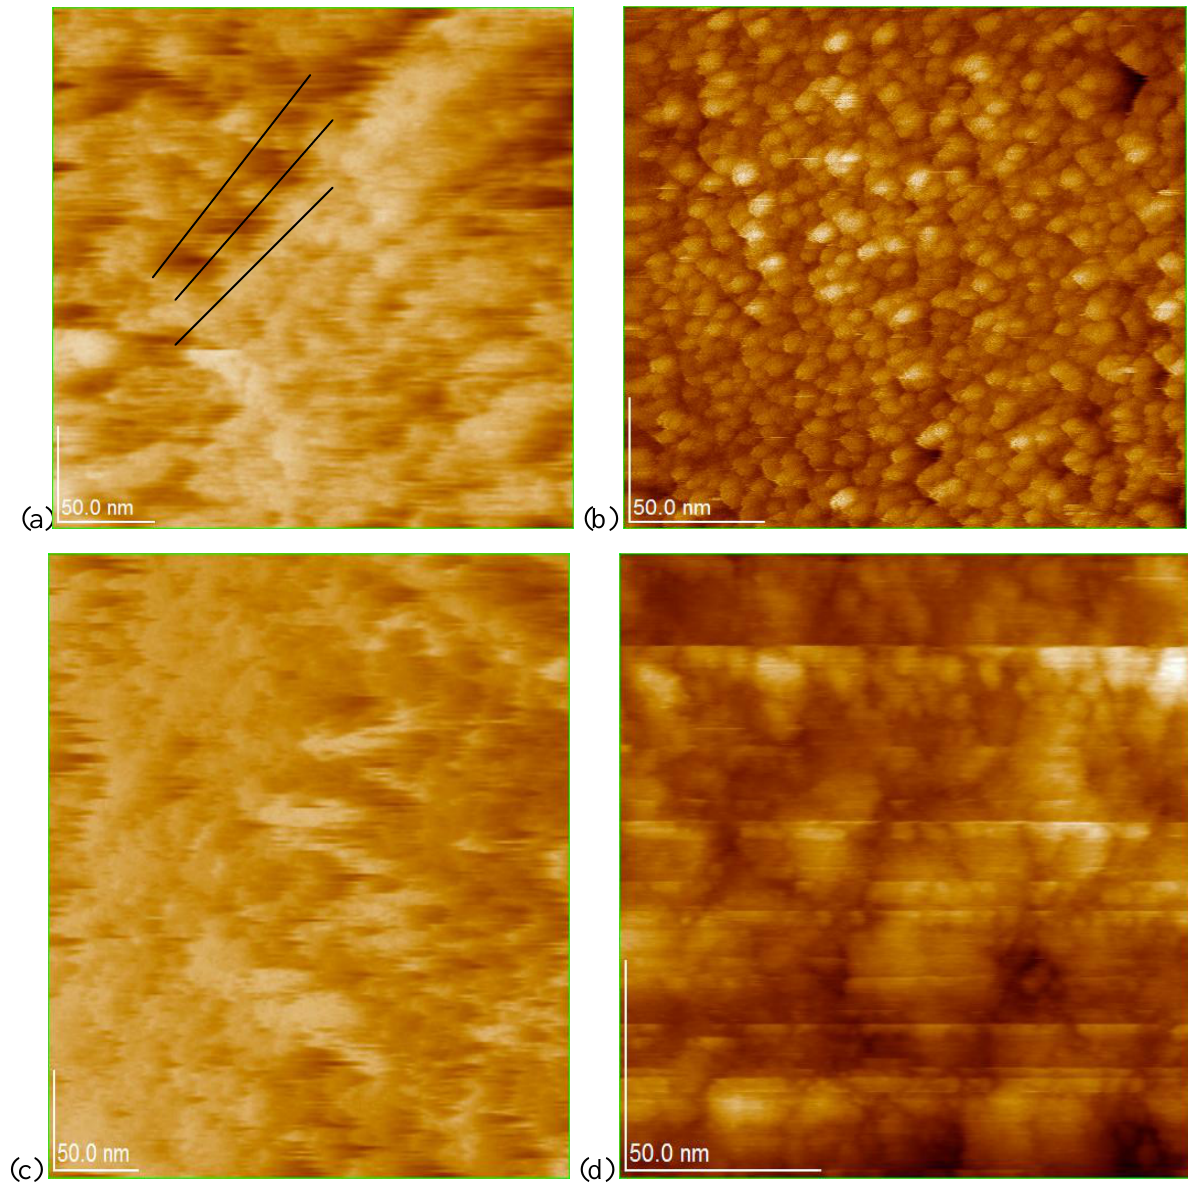
Figure 6. STM images of (a) Ni78Si8B14, (b) Ni70Mo20Si5B5, (c) Ni58Co20Si10B12, and (d) Ni25Co50Si15B10 after the OER. The images are obtained with a Pt-Ir tip at a bias voltage of 1.0 V and sample current 1.0 of nA in ambient air with atmospheric